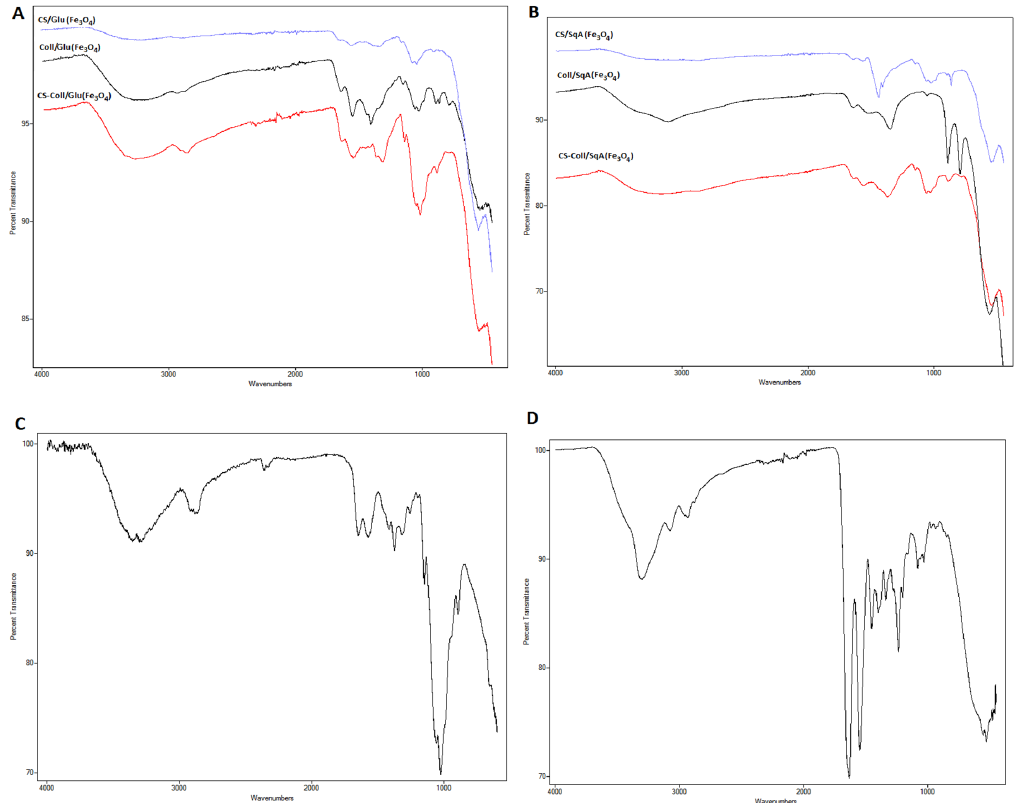
Figure 4. Attenuated total reflectance Fourier-transform infrared (ATR-FTIR) spectra of the obtained